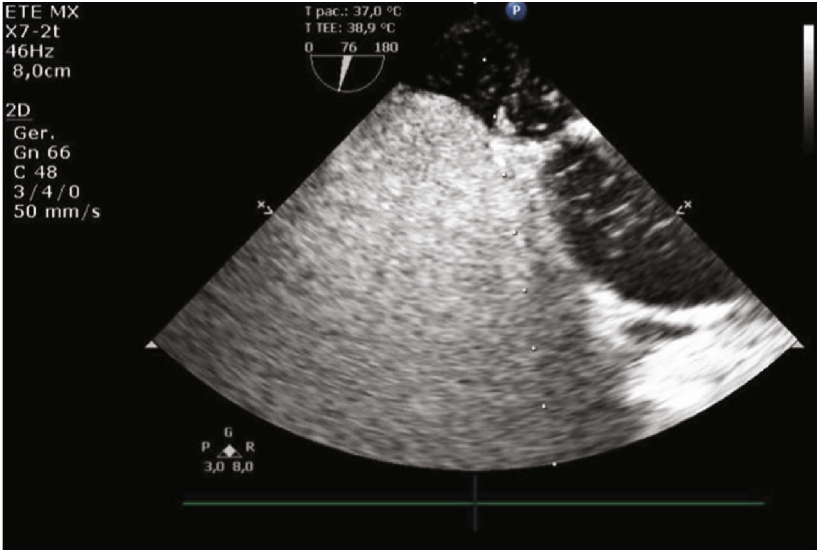
Figure 2: Transesophageal echocardiogram. Image revealing patent foramen ovale. After injection of agitated saline, a right-to-left shunt was